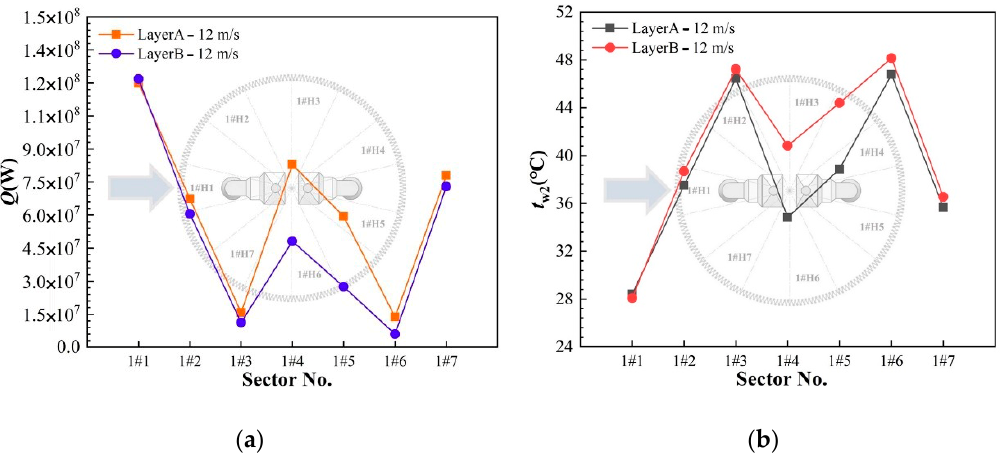
Figure 16. Heat rejections and water outlet temperatures of double-layer sectors under a typical crosswind of 12 m/s in the case of 1 unit. ( a ) Heat rejections ; ( b ) water outlet temperatures.